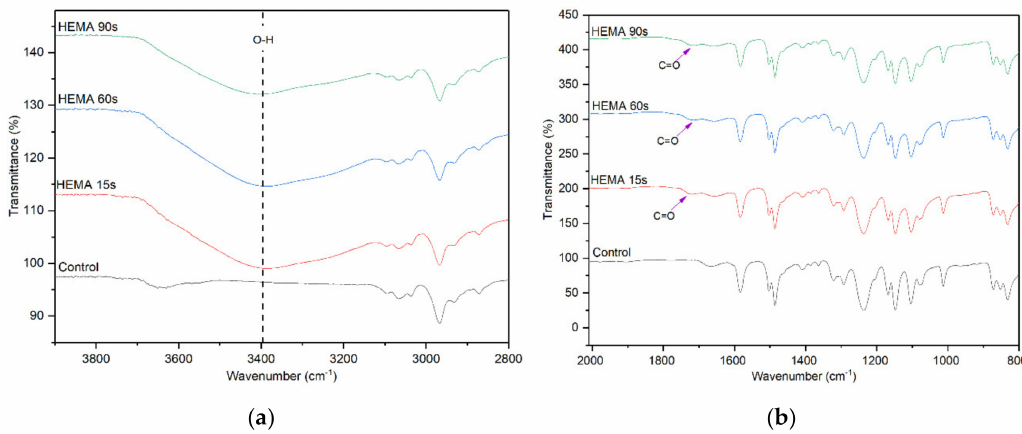
Figure 4. FTIR spectra of control membrane and HEMA-modified membranes, ( a ) wavenumber of 3800–2800 cm − 1 and ( b ) wavenumber of 2000–800 cm − 1